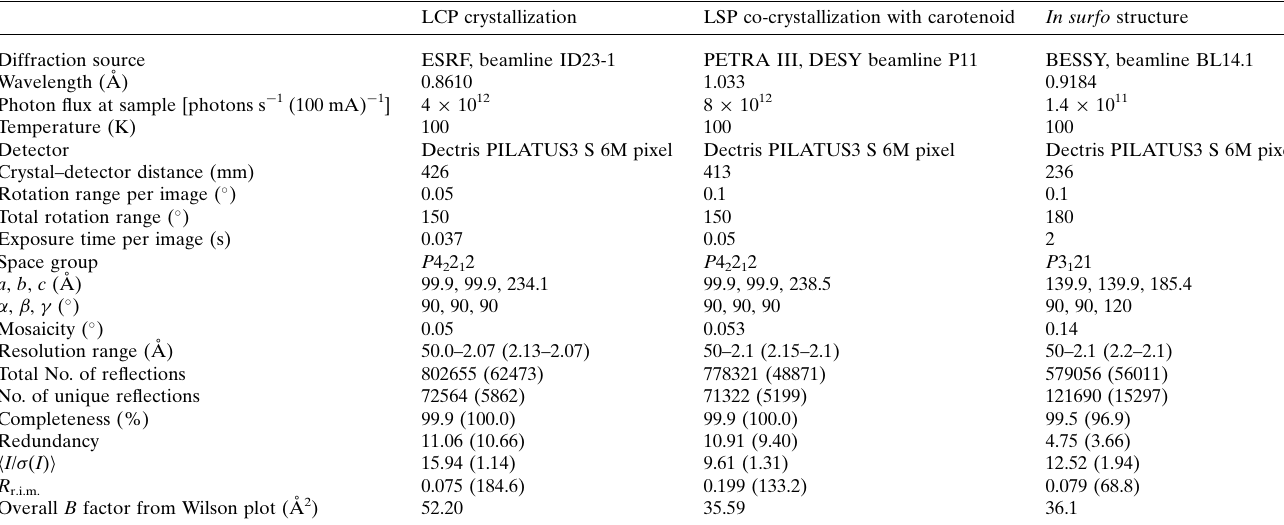
LCP crystallization LSP co-crystallization with carotenoid In surfo structure